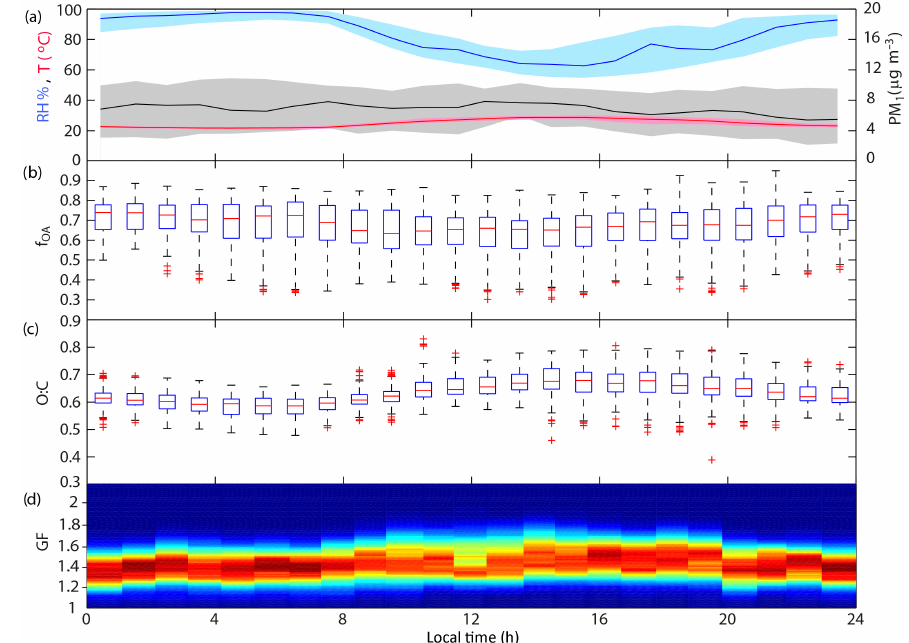
Figure 2. Diurnal profiles of (a) ambient temperature ( ◦ C), RH (%) and PM 1 (µgm − 3 ); (b) mass fraction of organics of the ambient particles ( f OA ); (c) degree of oxidation (O:C); and (d) median of the hygroscopic growth GF-PDF distributions (GF). Shaded areas in panel (a) and blue boxes in panels (b, c) represent quartiles ( q 25% and q 75% ) of the data which are averaged over 30min intervals. Black error bars represent data range calculated based on the distance to the quartiles ( q 75% − 1 . 5 (q 75% − q 25% ) ≤ x ≤ q 25% − 1 . 5 (q 75% − q 25% ) ). Data extremes (outside the error bars) are separated from the data and shown as red